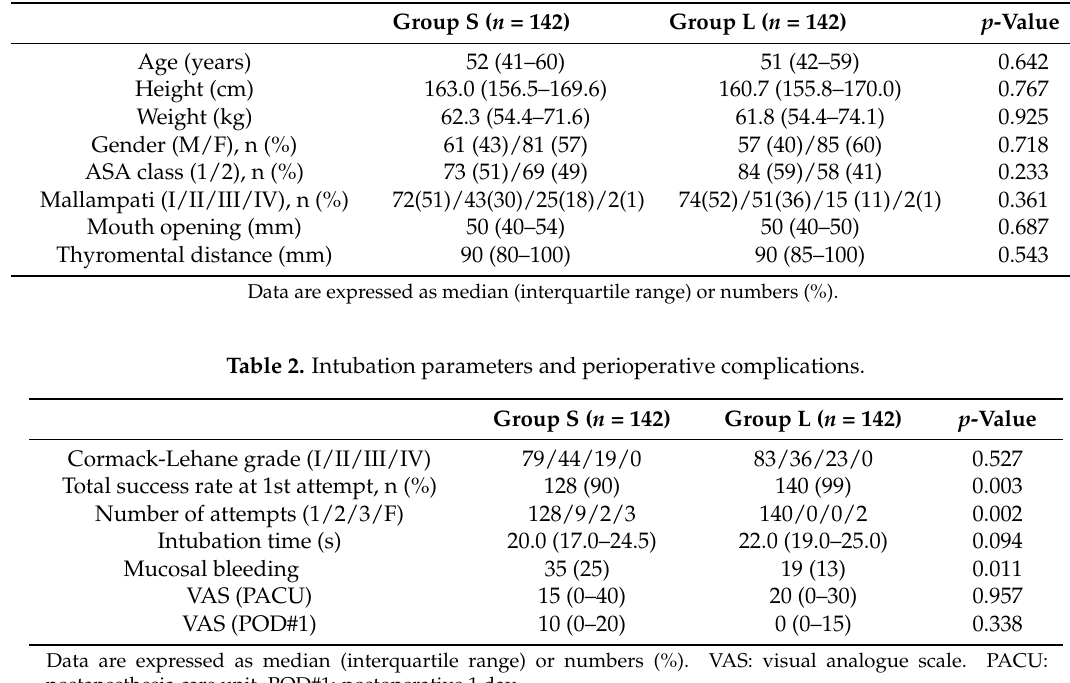
Table 1. Demographic data and preoperative airway evaluation.